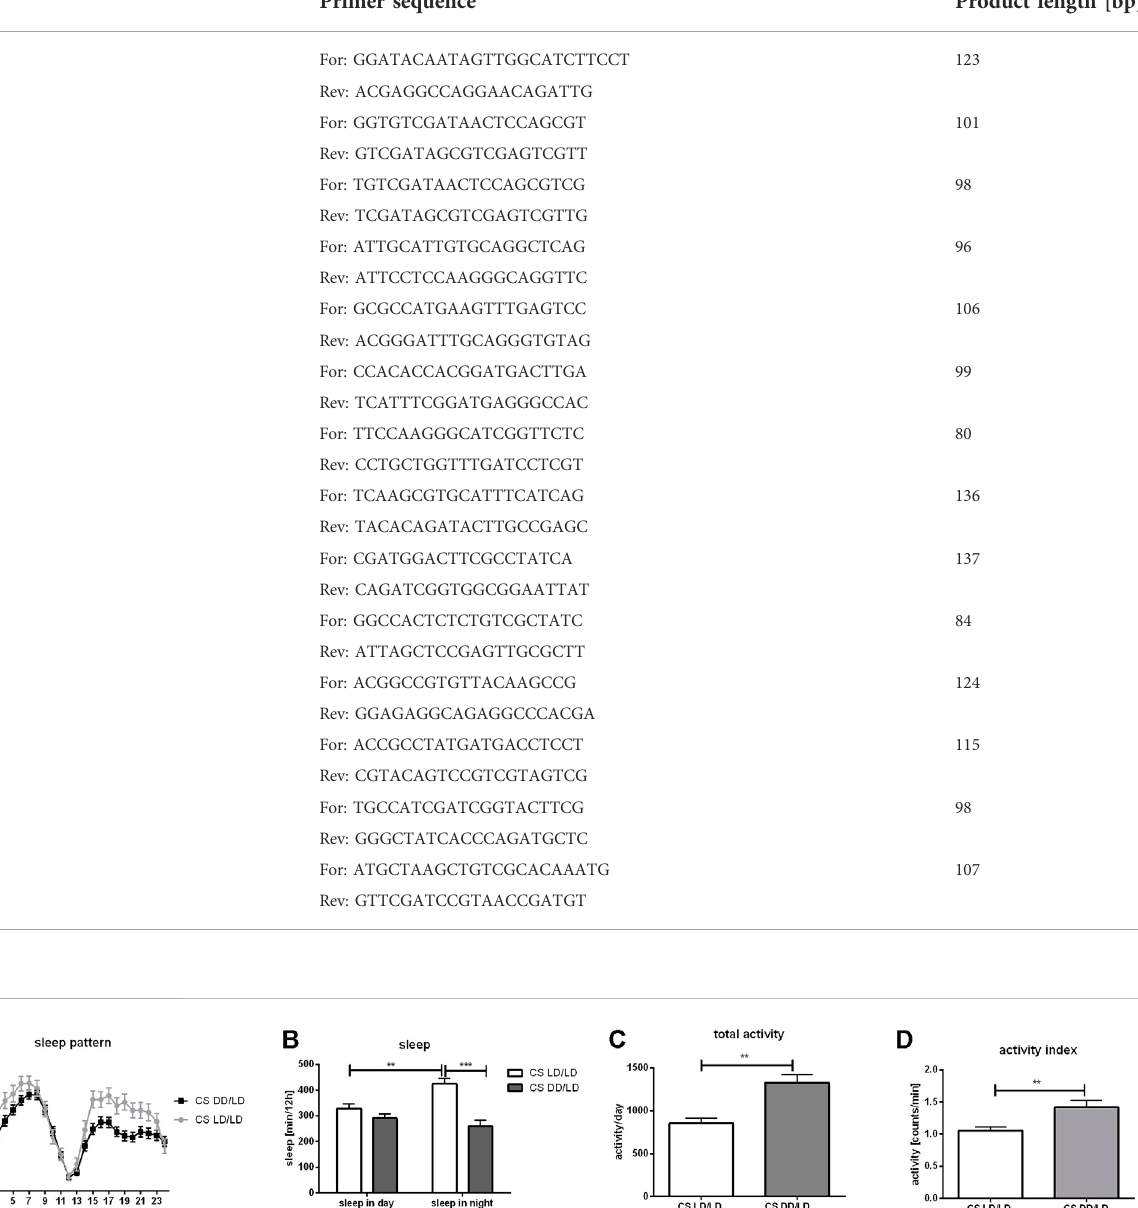
TABLE 1 Primer sequences used for qPCR.